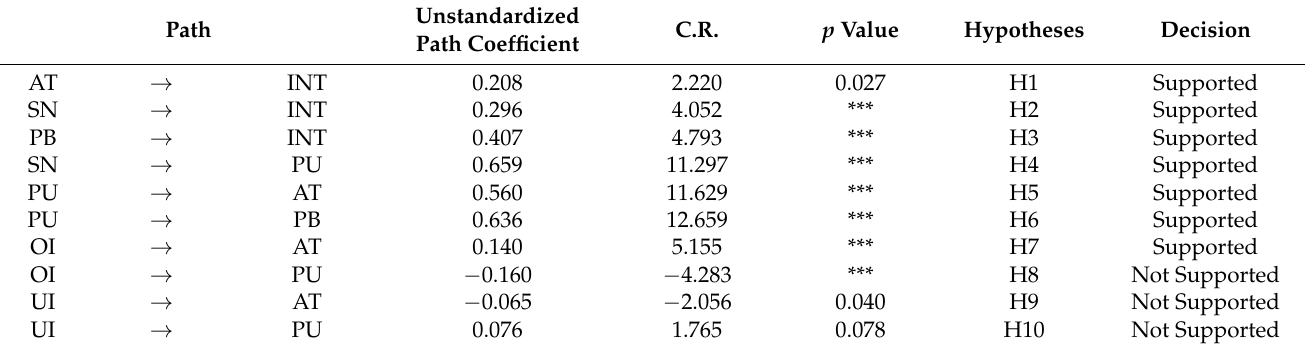
Figure 6. Analysis results of consumers’ purchase intention for HPWHs. Table 5. Hypothesis test results.